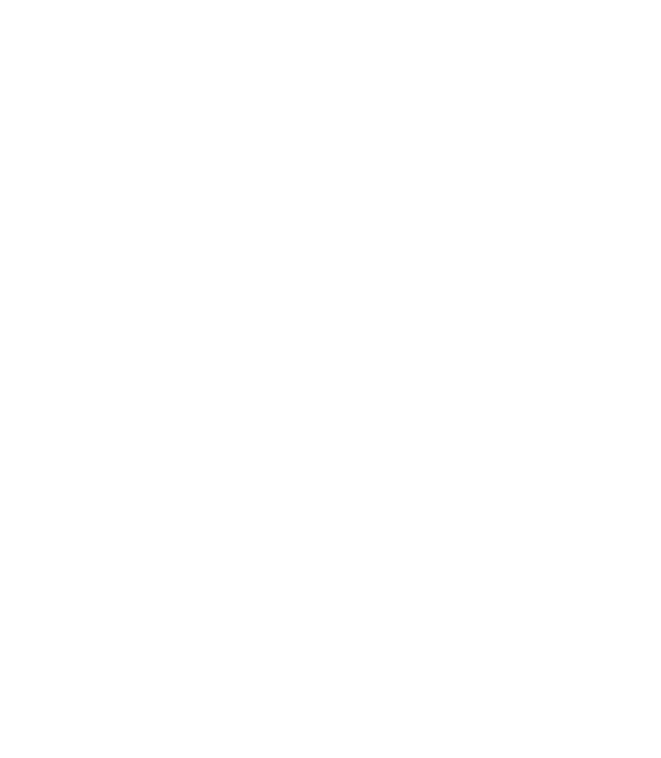
Figure 3. Representation of the graph based on the OpenStreetMaps import to uesgraphs , showing orange dots as detected buildings and grey dots and lines as street nodes and edges.